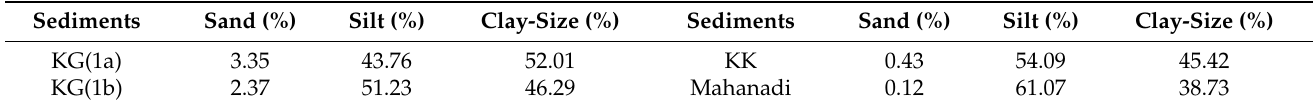
Table 4. Percentage of clay, silt, and sand particles in sediment samples.